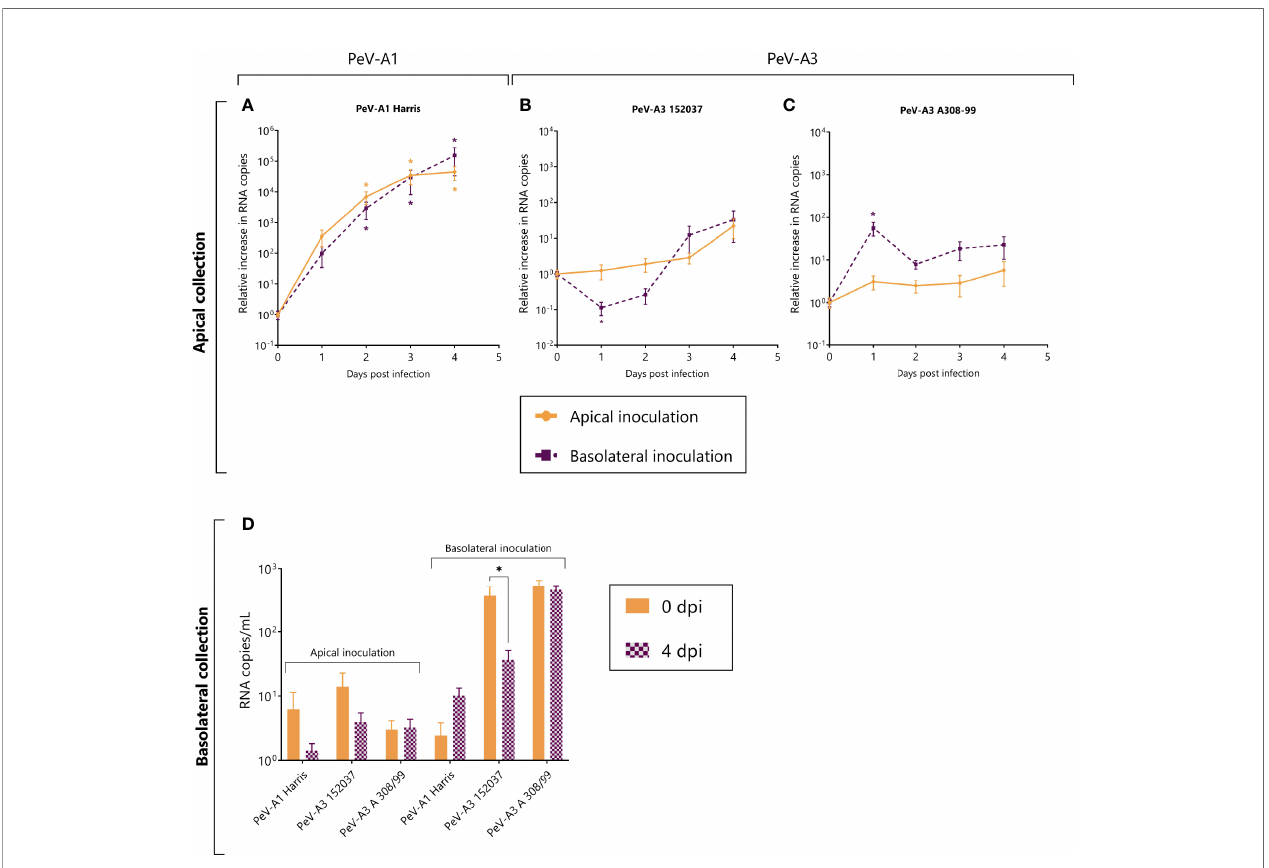
FIGURE 2 | Replication kinetics of lab-adapted strain PeV-A1 (Harris) and two lab-adapted PeV-A3 strains (PeV-A3 152037 and A308-99) in intestinal monolayers. (A – C) Represents the relative increase in RNA copies in samples collected from the apical compartment after both apical and basolateral inoculation. (D) Represents the total amount of viral copies at 0 dpi and 4 dpi in the basolateral compartment, after either apical or basolateral inoculation. In all cases, data represent the mean ± SEM of two technical replicates in three biological replicates. * p -value < 0.05. dpi = days post